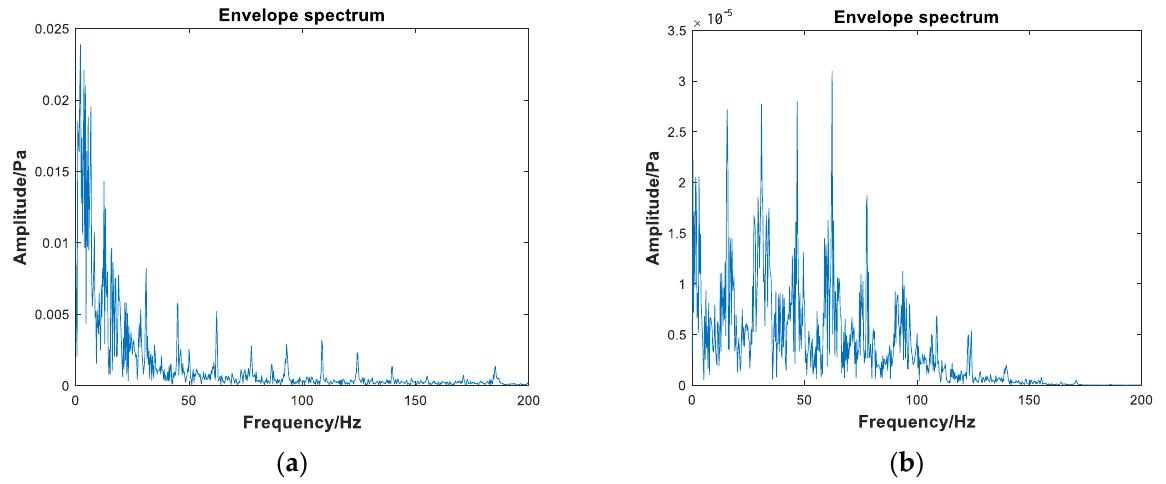
Figure 12. ( a ) Envelope spectrum of the Robinson R44 helicopter before filtering at 4.114 km; ( b ) Envelope spectrum of the Robinson R44 helicopter after filtering at 4.114 km.